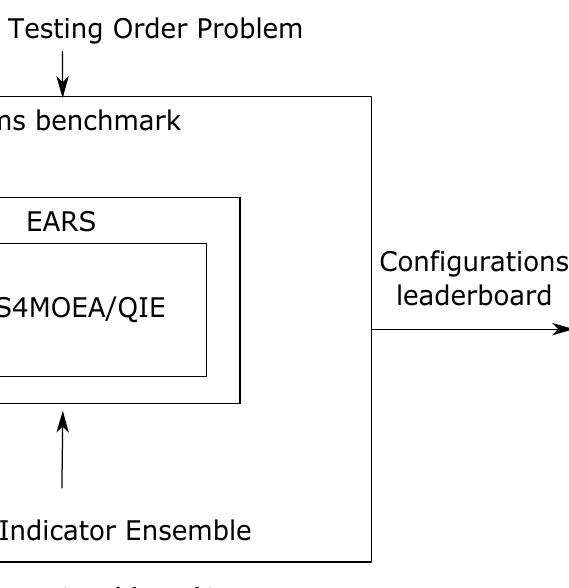
Figure 4. Experimental execution of the ranking